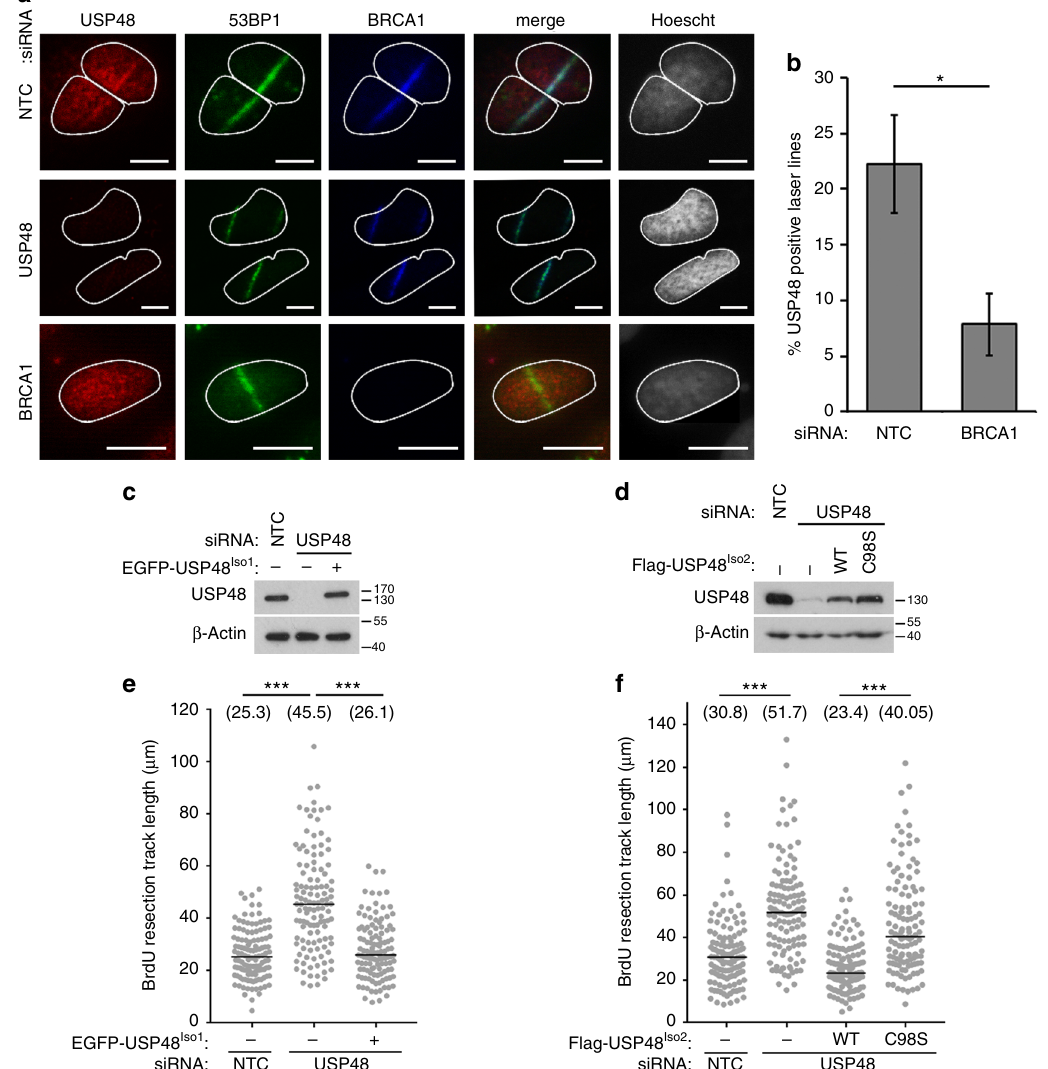
Fig. 3 USP48 deubiquitinase activity restrains resection. a USP48 is recruited to sites of damage. BrdU-sensitized HeLa cells were subjected to laser stripe IR followed by fi xation after 30 min and staining for endogenous USP48, BRCA1, and 53BP1. Scale bar = 10 µ m. In the middle and lower panel, cells were treated with USP48 (exon 5 and exon 11 targeting sequences) and BRCA1 siRNA, respectively. USP48 siRNA treatment utilized exon 5 and exon 11 targeting sequences together throughout the manuscript, unless otherwise stated. b Percentage of USP48-positive laser lines in control vs BRCA1-depleted cells. Graph is mean from three independent experiments. Error bars are SEM and * p < 0.05 Student ’ s T -test. c , d Expression levels of USP48 in stable HeLa-FlpIn cell lines following depletion of USP48 and DOX-induced expression of siResistant EGFP-USP48 Iso1 c or Flag-USP48 Iso2 -WT or Flag-USP48 Iso2 - C98S d . e , f USP48 depletion increases resection lengths. Resection lengths were measured in HeLa cells depleted for USP48 and complemented as in c and d . Cells were incubated with 10 mM BrdU for 24 h with addition of 10 µ M Olaparib for the fi nal 16 h. Cells were lysed and DNA fi bres spread before staining for BrdU-positive single-stranded DNA resection tracks. One hundred and twenty fi bres were measured using ImageJ for each condition. Bars indicate median, also shown numerically in brackets. *** p < 0.005 Mann – Whitney